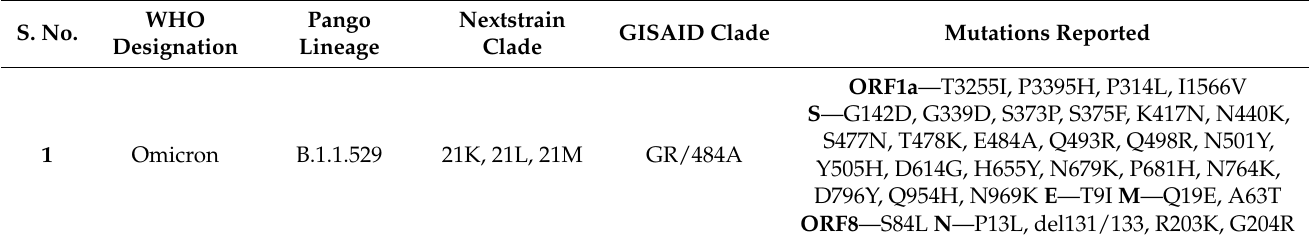
Table 3. Current circulating VOC and mutations